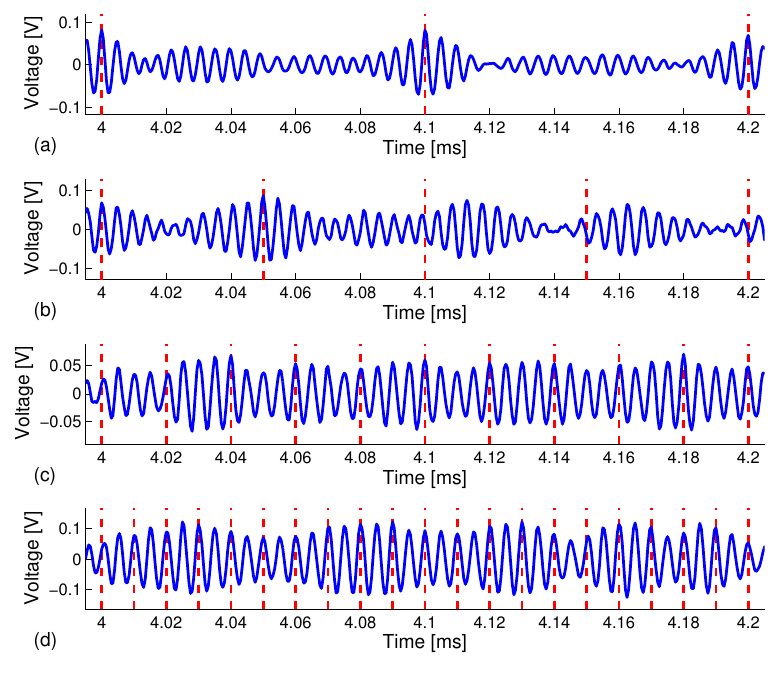
Figure 10. Snapshots of the received information carrying waveforms in the time window of 4 . 0 ms - 4 . 2 ms obtained from a stainless steel pipe specimen filled with water. The data rates are: ( a ) 10 kbps; ( b ) 20 kbps; ( c ) 50 kbps; and ( d ) 100 kbps.